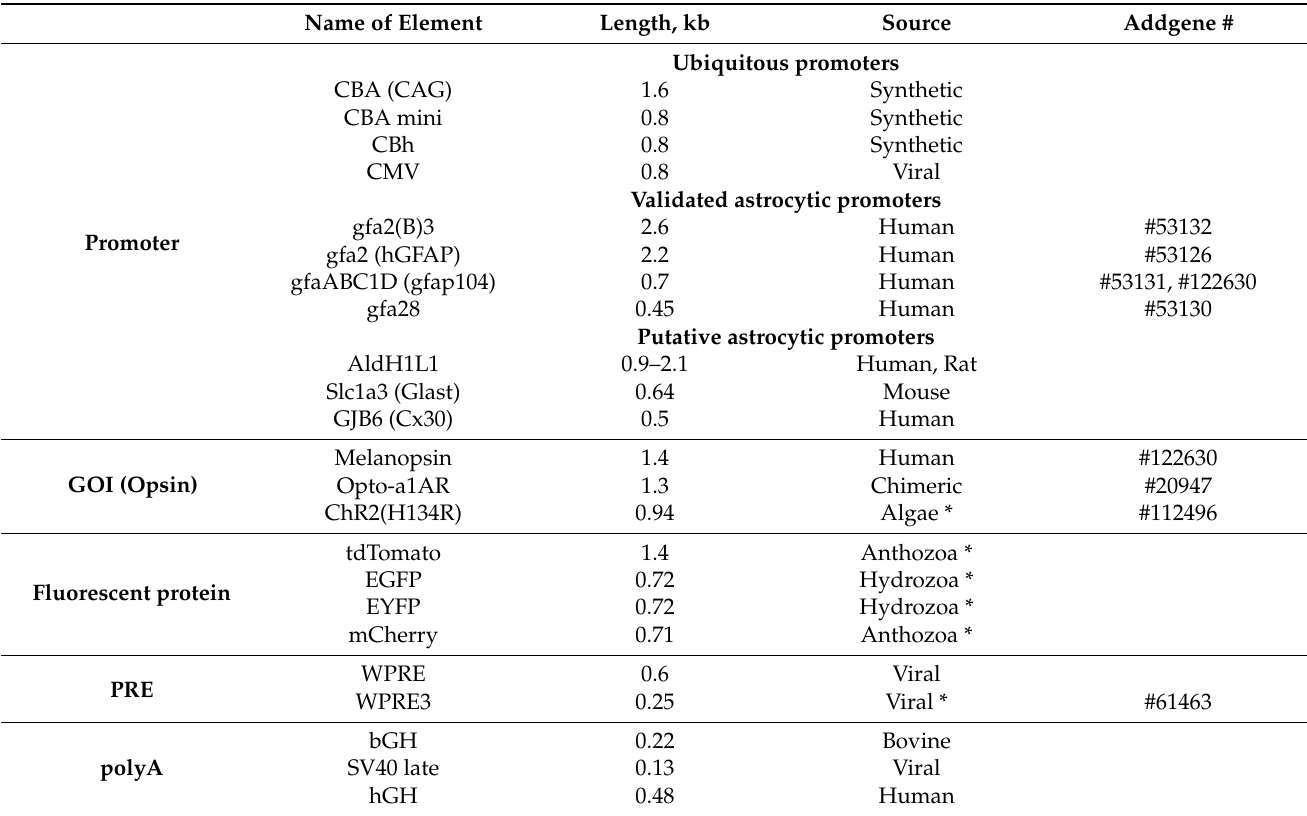
Table 1. A list of various promoters, genes of interest (opsins), fluorescent reporter proteins, and regulatory elements that can be used to design the genetic construct for efficient transgene expression. For each element, relative length (kb), source, and/or Addgene catalog indexes (#) are provided. GOI—gene of interest; PRE—post-transcriptional regulatory element; polyA—polyadenylation